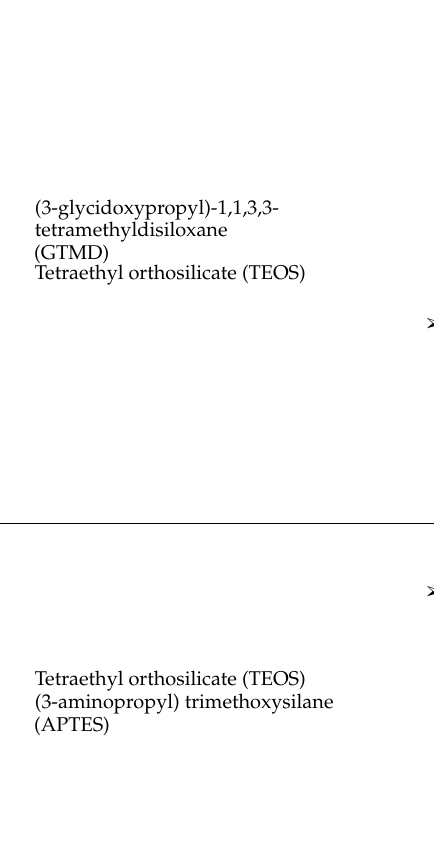
Table 1. Different approaches for improving silane coatings and the main findings, as reported in the literature. Silane(s) Used Coating Preparation Main Findings Ref.